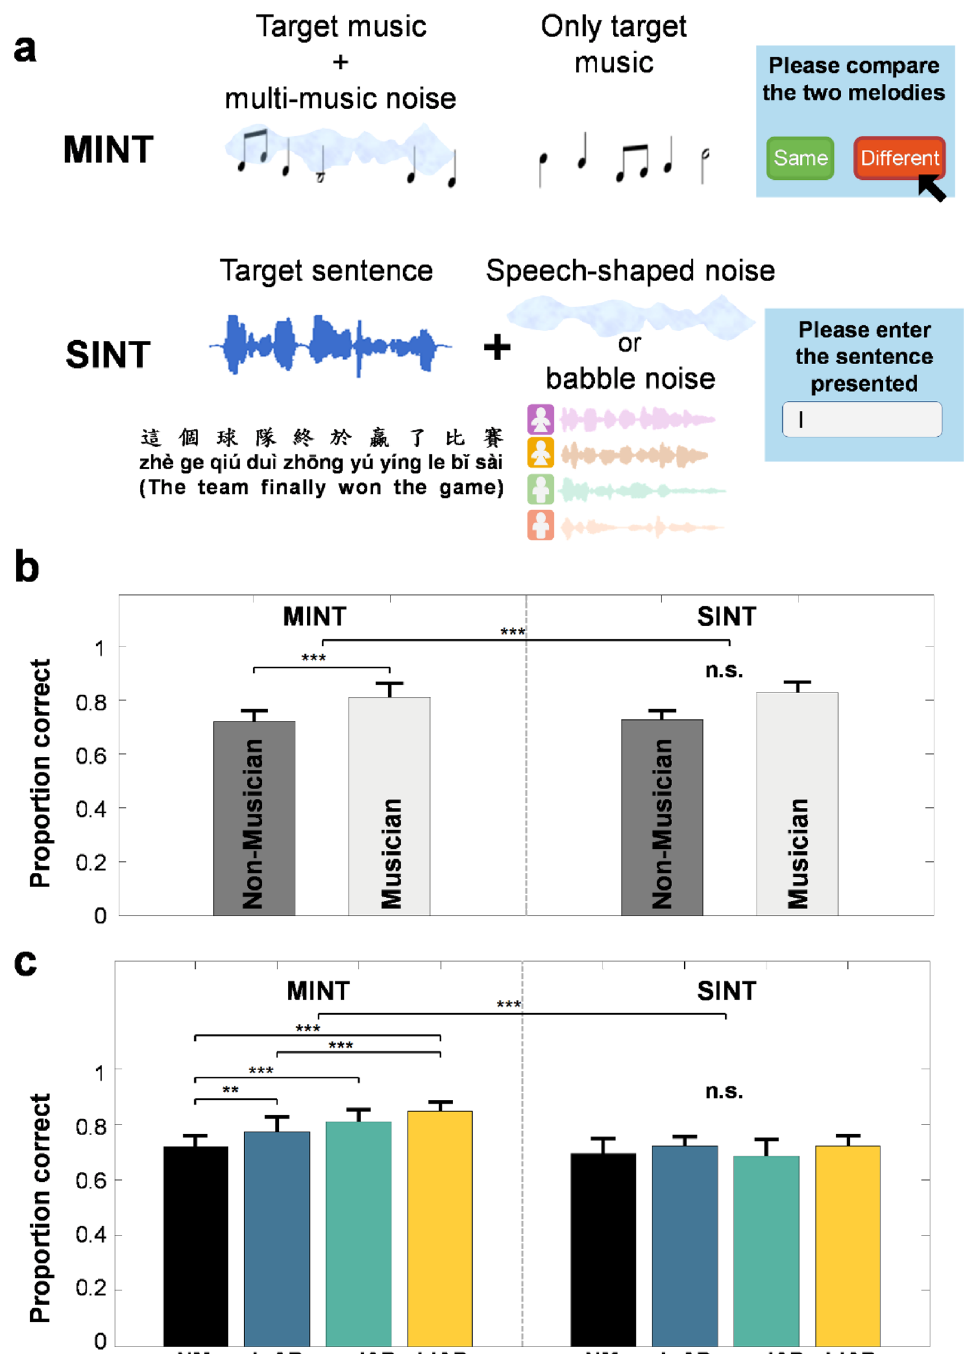
Figure 2. Average performance accuracy on music-in-noise and speech-in-noise tasks as a function of musicianship and quasi-AP proficiency level. ( a ) Schematic diagram of the music-in-noise and speech-in-noise tasks. ( b ) Mean proportion correct on MINT and SINT performance by musician and non-musician groups. ( c ) Mean performance accuracy on MINT and SINT separated into 4 groups based on quasi-AP proficiency level. Error bars represents ± 1 SD. ***p < 0.001, **p < 0.01, *p < 0.05 level of significance; n.s. not